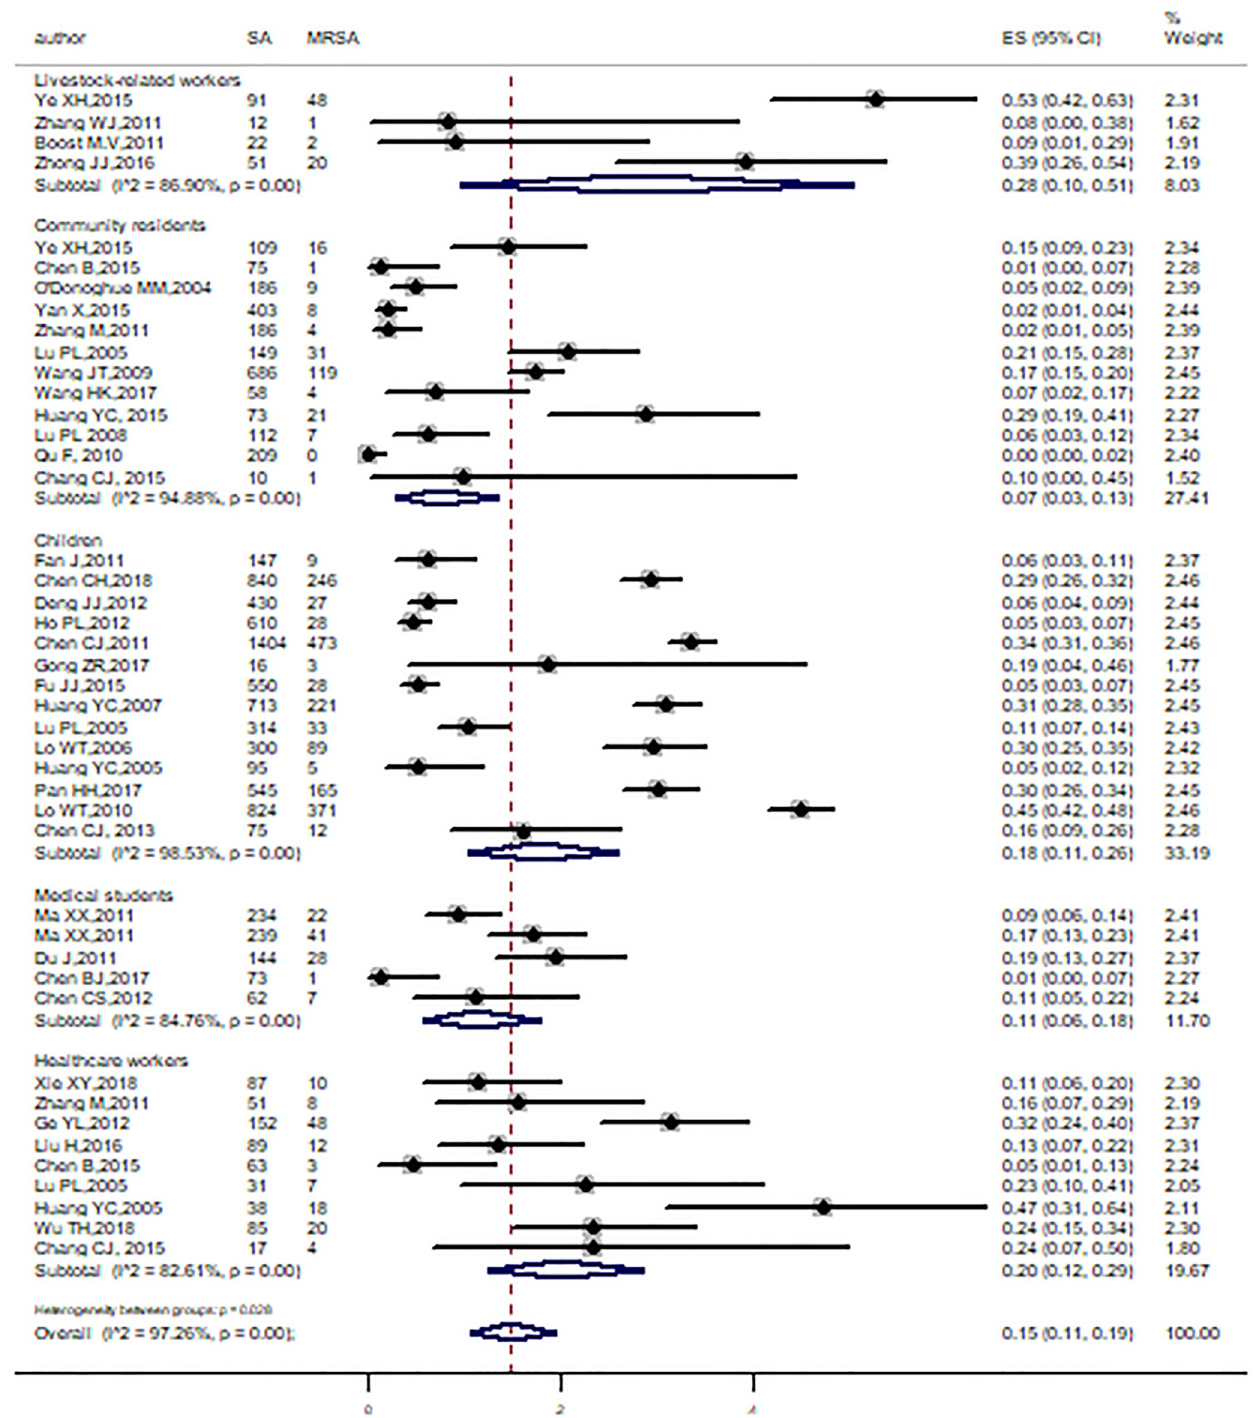
Fig 5. Subgroup analysis for the prevalence of MRSA by